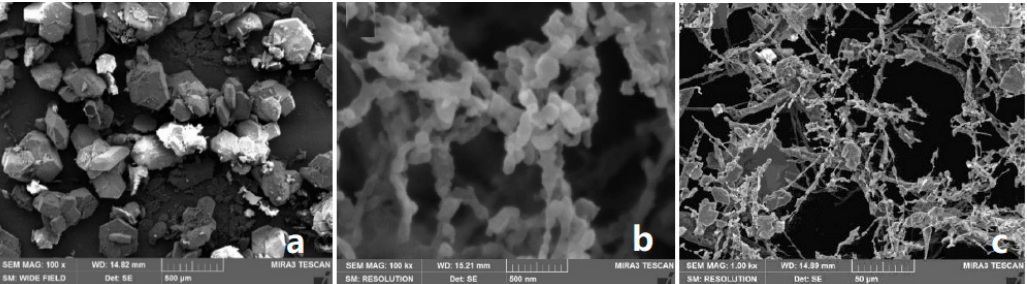
Figure 6. SEM images of different particles. ( a ) Raw mHATO particles; ( b ) nHATO prepared with SFL method; ( c ) nHATO prepared with FD method. Reproduced from [50], with permission from North University of China: Taiyuan, China,